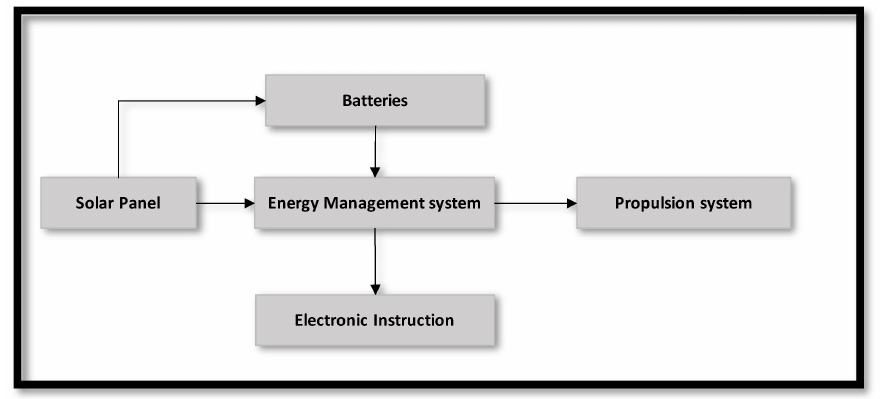
Figure 1. Renewable power system of stratospheric airships